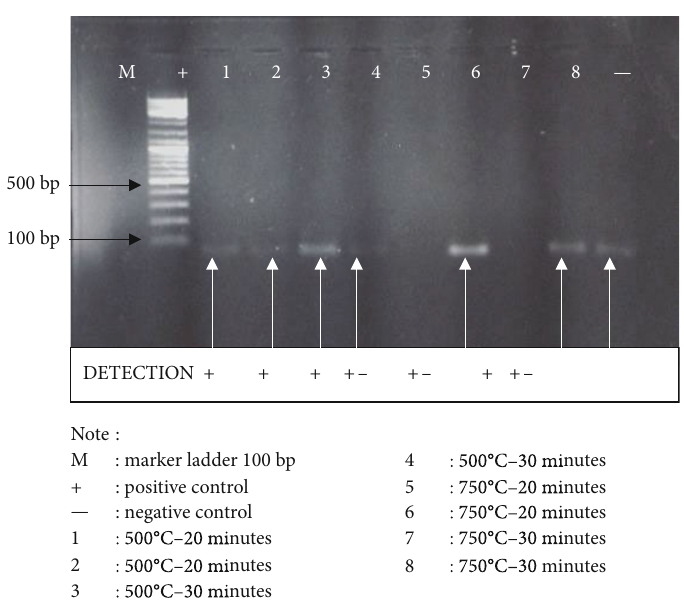
Figure 2: Visualization of CSF1PO locus of the tooth sample PCR results using a mini